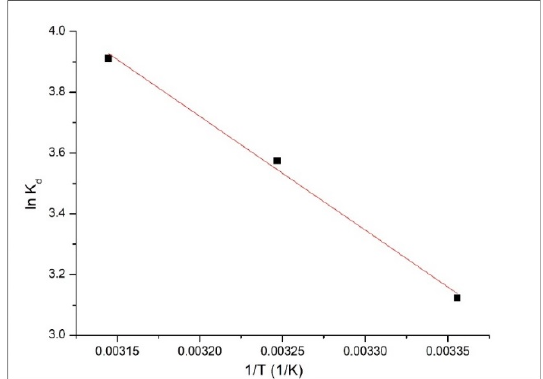
Figure 9. ln K d versus 1/T plot obtained for Cd adsorption on Ch-HDTACl.